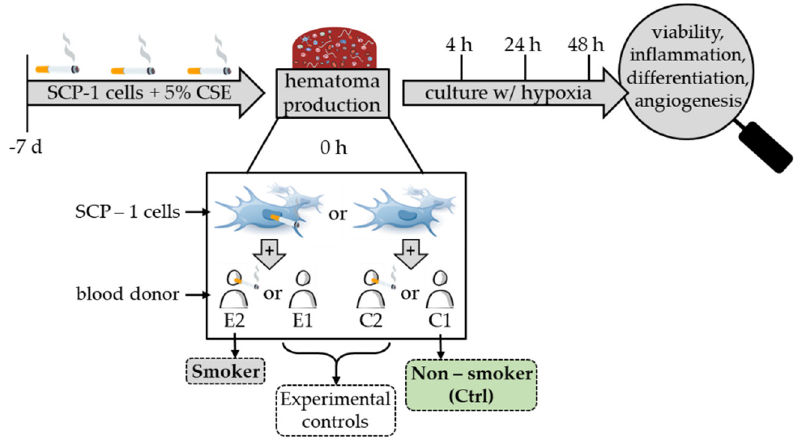
Figure 1. Experimental setup and conditions.